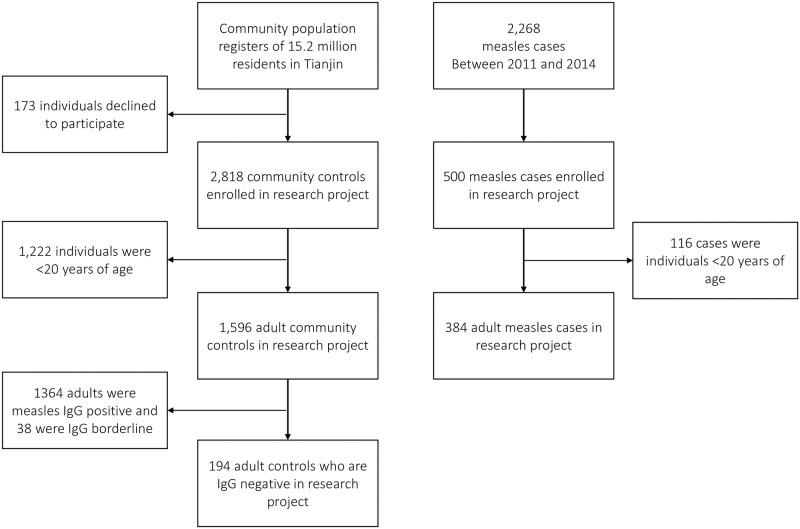
Diagram of how control and cases were enrolled into the study.